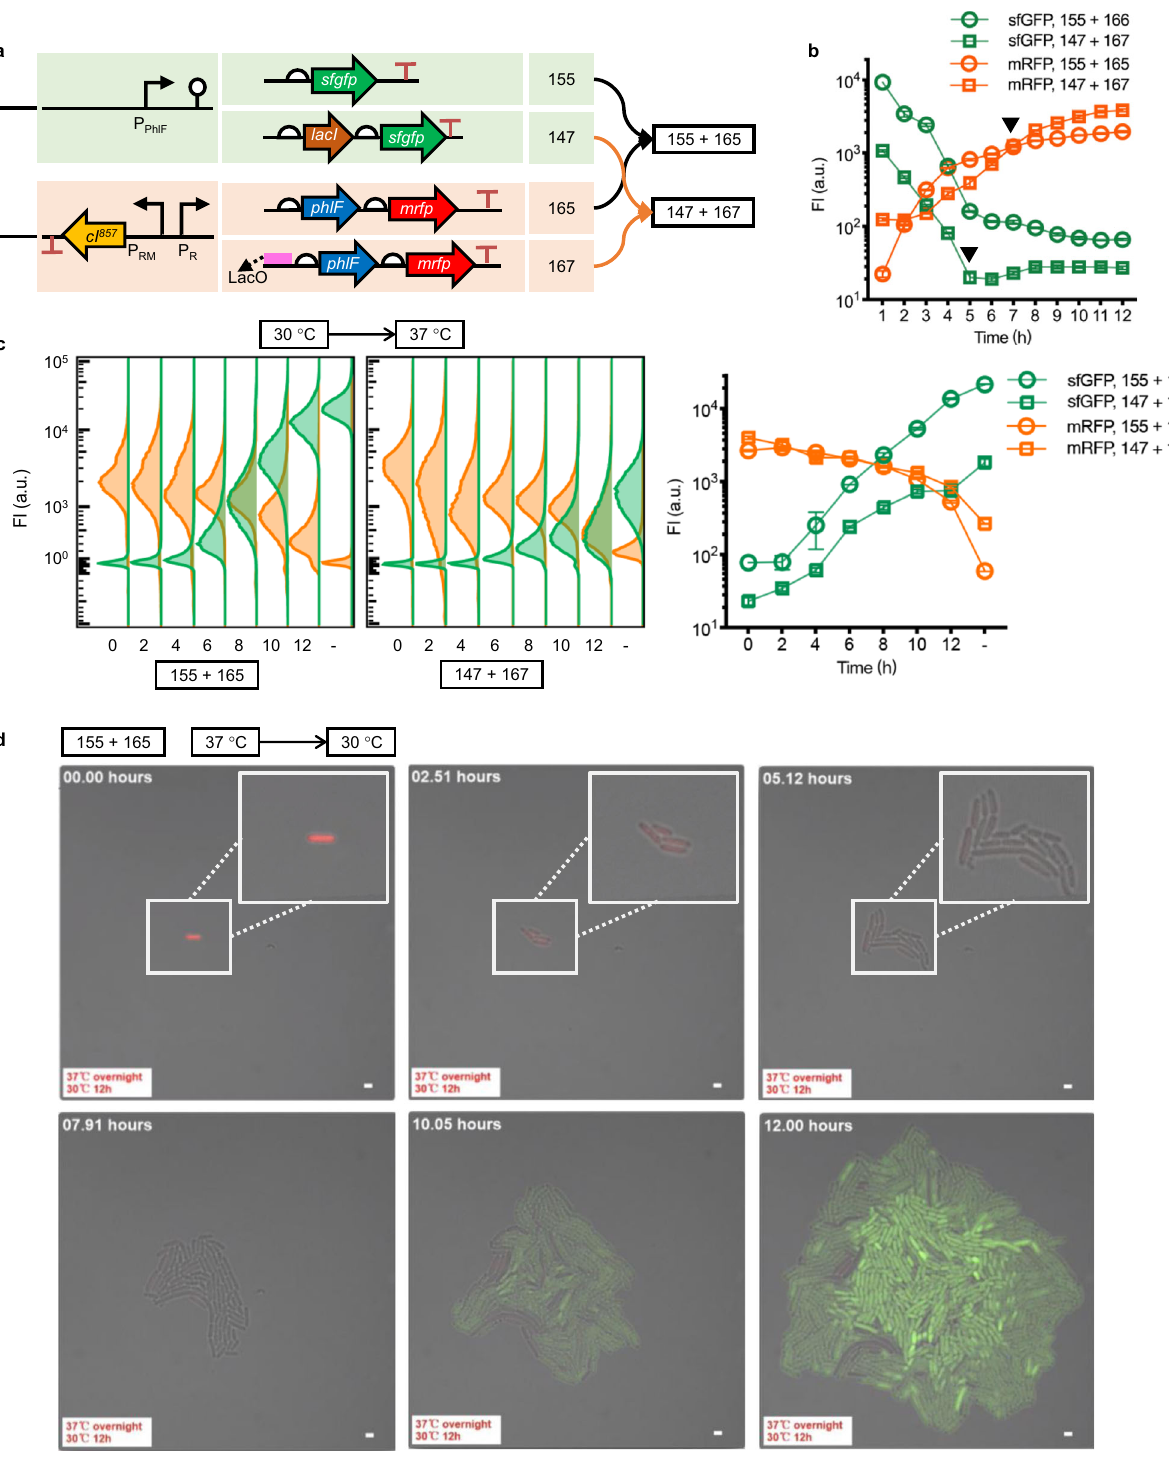
Fig. 2 Switch-testing of bifunctional on- and off-responses. a Constructs based on T-switch, the 155 + 165 group, by introducing negative feedback loop control of input signals, namely 147 + 167 group. lacI gene was co-expressed with sfgfp to stringently repress the promoter activity of P R with the downstream insertion of a LacI-associated operator, LacO. b Fluorescence intensity (FI) monitoring of time course of T-switch circuits by altering temperature from 30°C to 37°C right after inoculation to characterize the response-curve under thermal inductions. Cells were grown at 30°C throughout the pre-cultivation from a single colony. c On- and off-response performance of T-switch constructs shown in a in different growth phases. Recombinant cells were grown for 12h after changing temperature from 30°C to 37°C. Left: distribution and variance of fl uorescence, including sfGFP and mRFP, monitored using a fl ow cytometer; right: quantitative comparisons of on/ off performances. Data in b and c are presented as mean±s.d. of three replicates. d 12h Time-lapse photography of the temperature-responsive performances of engineered E. coli harboring T-switch, and constructs 155 + 165, during a shift from 37°C to 30°C. Samples comprising 1 µ L of the cell suspension were injected and incubated underneath a layer of solid LB with 1.0% agarose (~1.5mm) containing the relevant antibiotics at 30°C from overnight cultures at 37°C. Since the tightness and ultra-sensitivity of tetR family repressor PhlF, the activation of sfGFP lagged behind the quenching of mRFP by at least